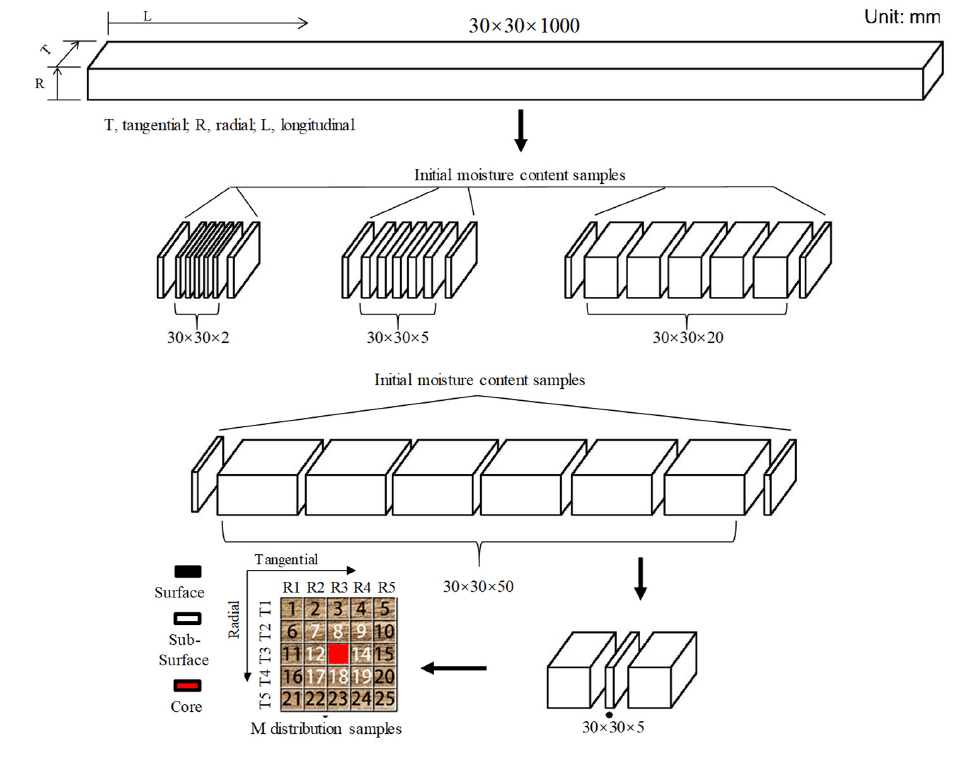
Figure 1. Wood sampling diagram.